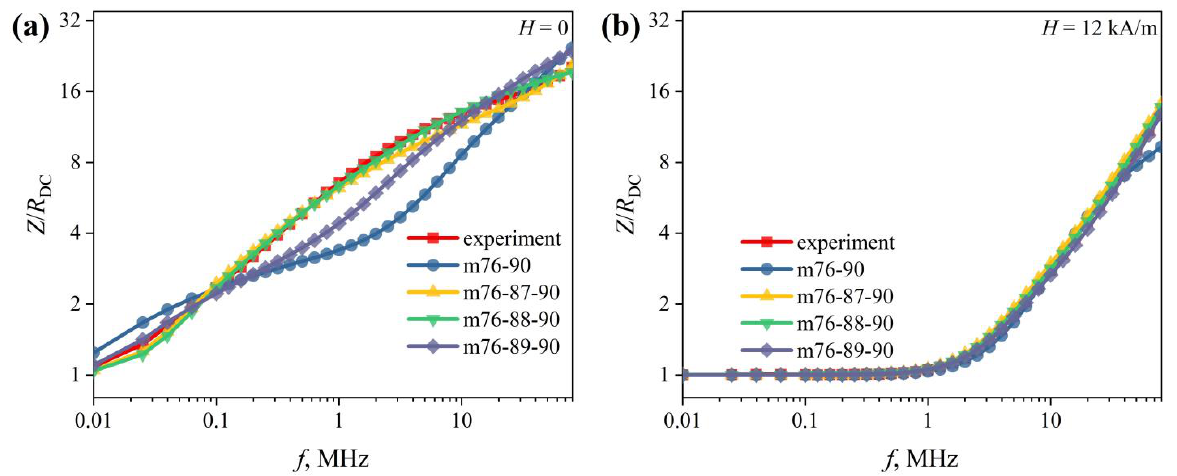
Figure 10. Reduced impedance versus AC frequency Z ( f )/ R DC . Experimental results were obtained in the magnetic fields H with intensity ( a ) 0; ( b ) 12 kA/m. The values of the magnetic permeabilities µ i used in the modeling are shown in the